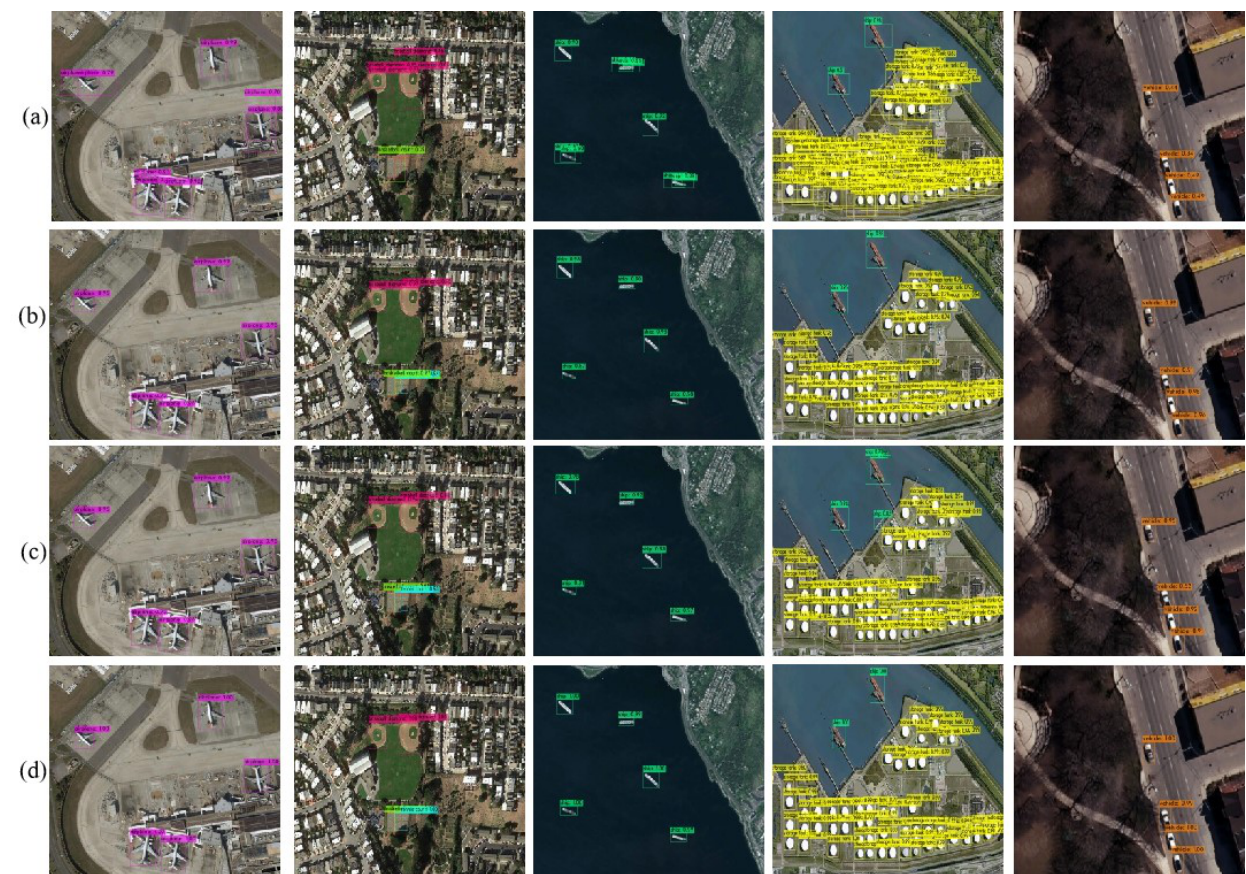
Figure 9. Visual detection results of different feature enhancement module.